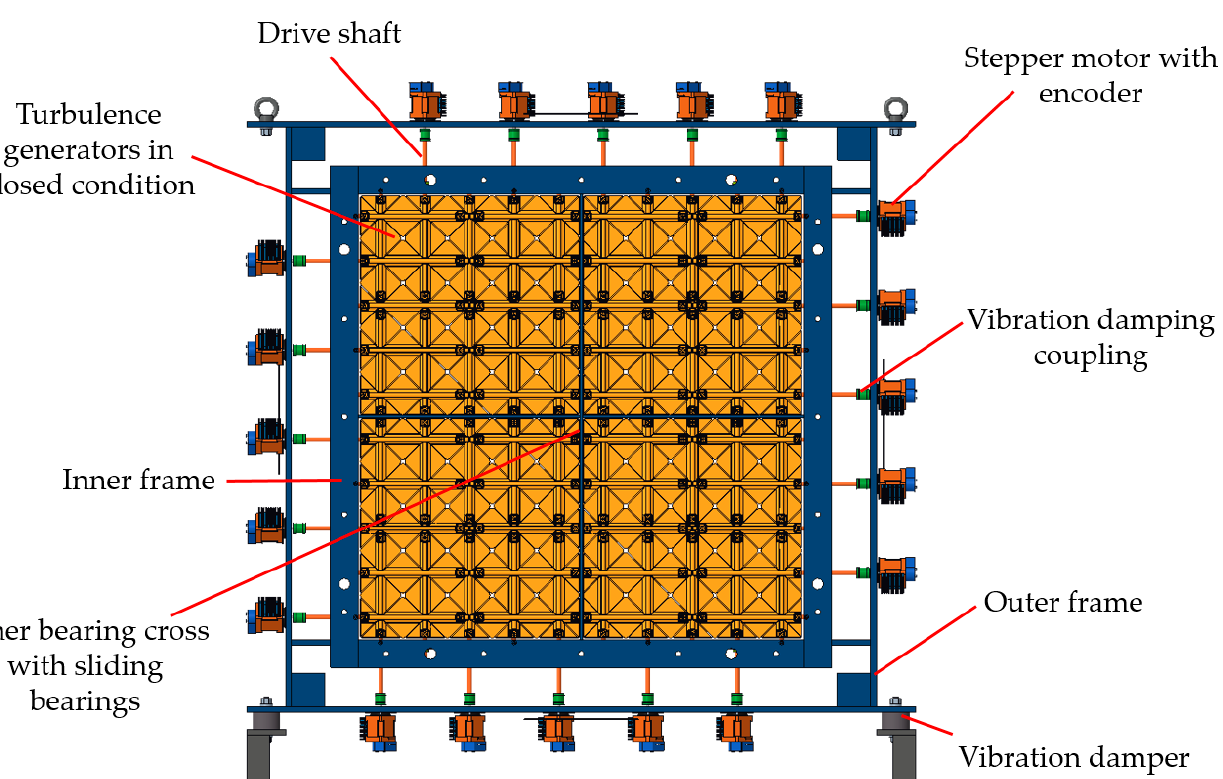
Figure 4. Schematic representation of the basic structure of the active turbulence grid.